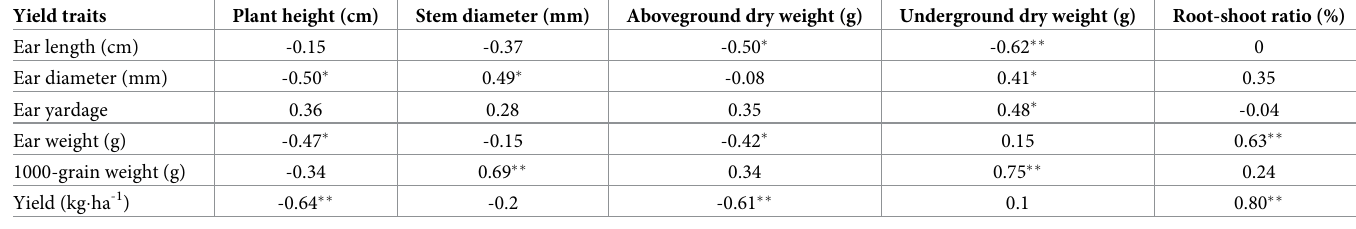
Table 2. Correlation coefficients between growth indicators and yield